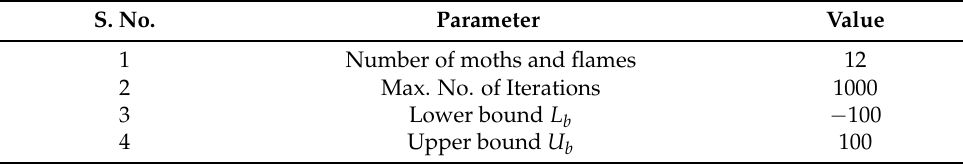
Table 9. Moth–flame optimization (MFO) algorithm parameters. S. No. Parameter Value 1 Number of moths and flames 12 2 Max. No. of Iterations 1000 3 Lower bound L b − 100 4 Upper bound U b